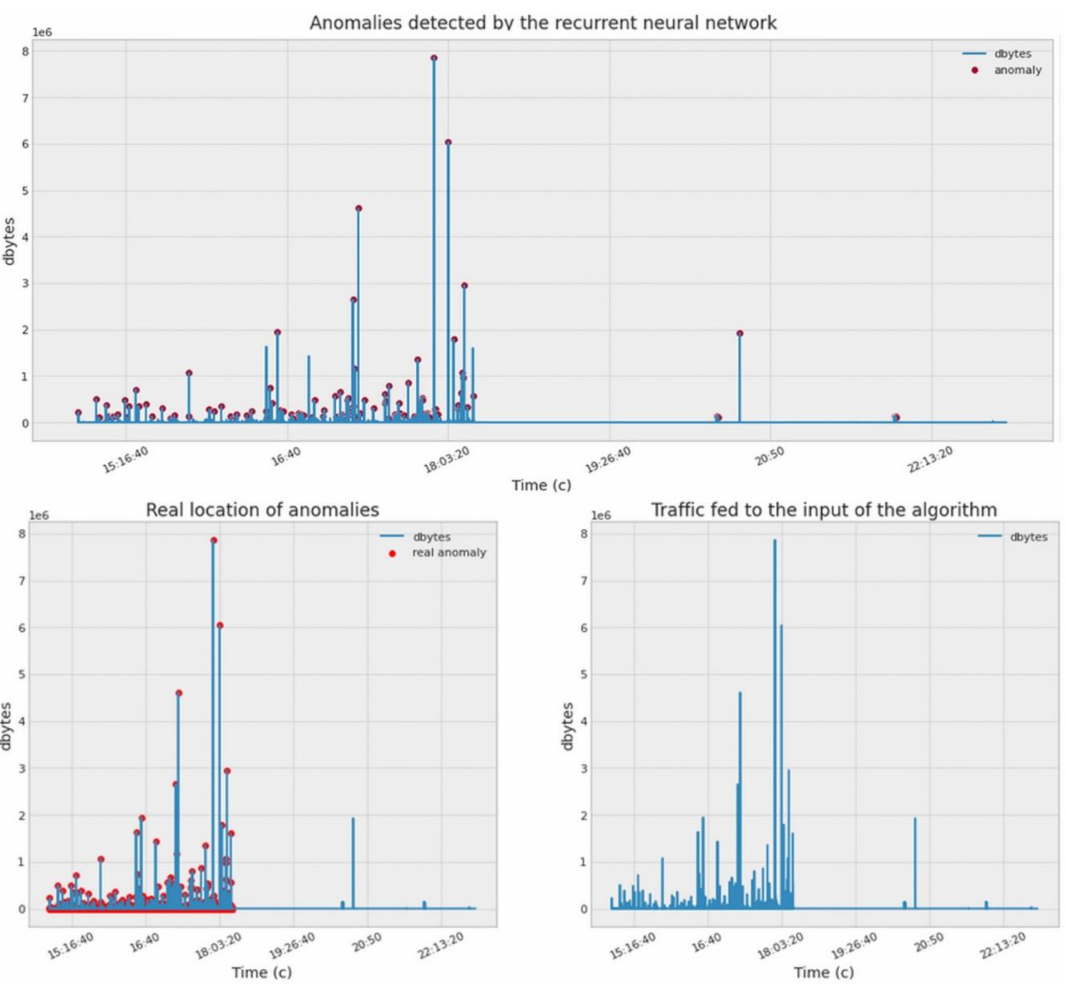
Figure 31. The result of the algorithm.